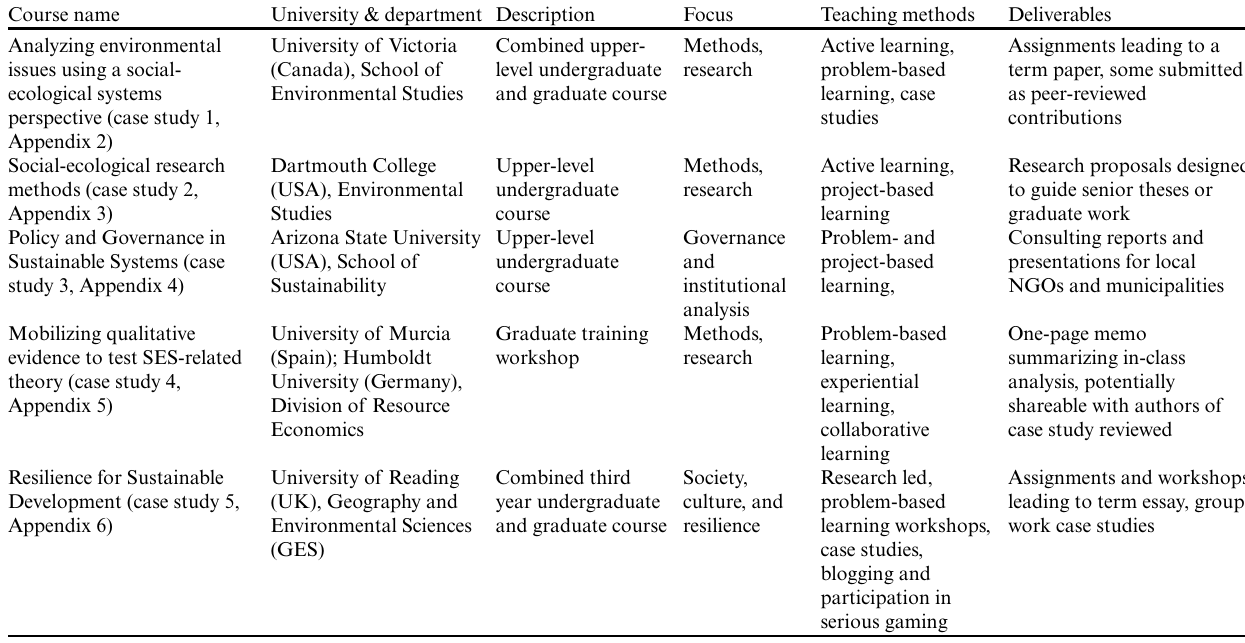
Table 1 . Courses used as case studies in this